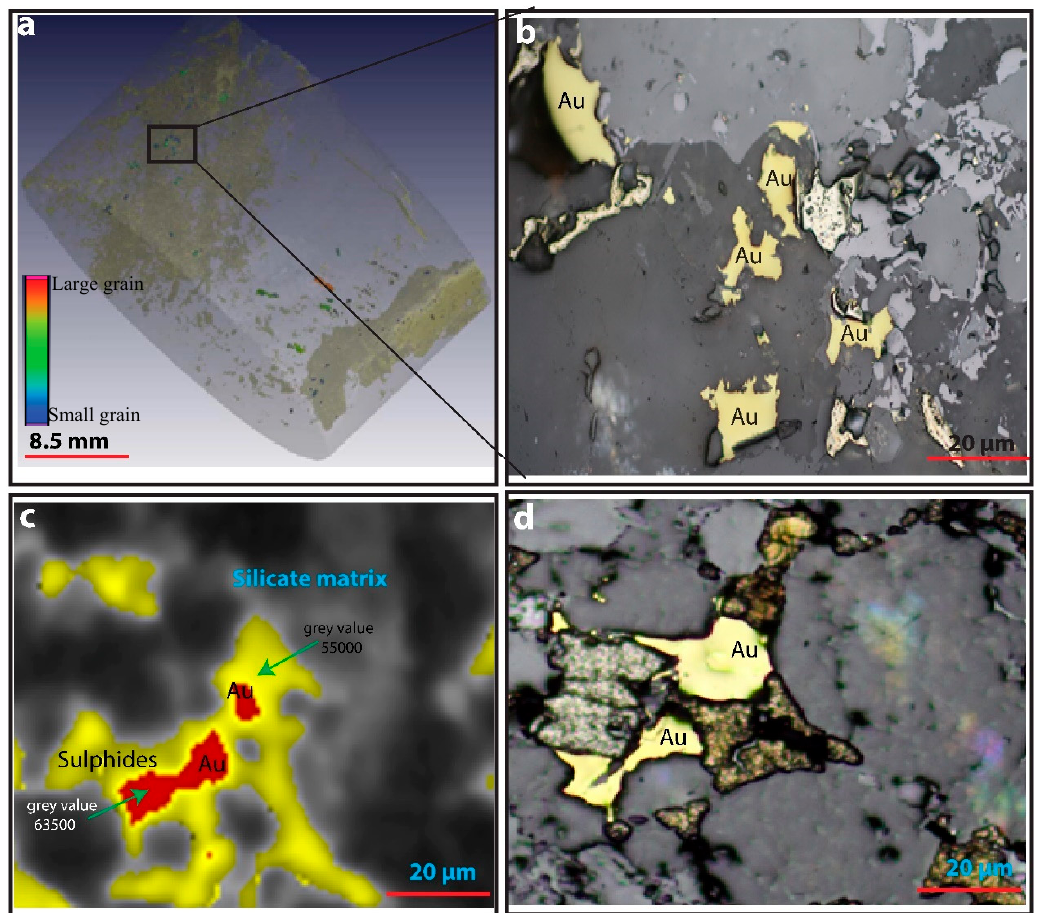
Figure 2. X-ray computed tomography and reflected light images indicating gold grains identified in XCT and gold grains identified in reflected light microscopy. ( a ) The drill core was cut on the rectangle shown to make thick sections. Grey colour in the drill core is the silicate matrix, the yellow colour indicates sulphides and other colours represent gold, distributed according to gold grain volume (warm colours = large grains, cold colours = smaller grains). ( b ) Reflected light microscopy shows ubiquitous presence of gold, which proves that the dense minerals we see in XCT are indeed gold. ( c , d ) Gold grain in XCT, same grain in reflected light microscopy. In Figure 2c, the yellow colour indicates sulphides, dark colour indicates silicate matrix and red colour indicates gold. Figure 2c is coloured according to density (warm colours = most dense gold grains, yellow colours = medium density sulphides, dark / grey colour = less dense silicate matrix).